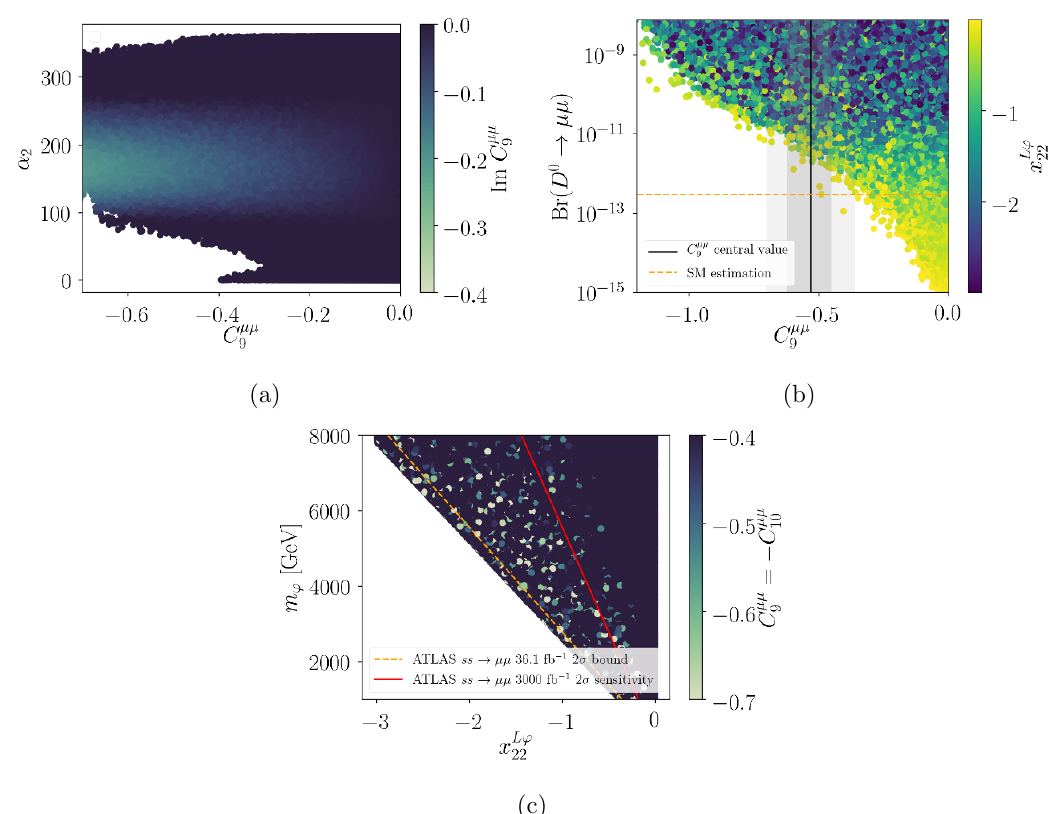
Figure 18. The other interesting results of our Monte Carlo analysis. (a) The relation between C (cid:22)(cid:22) and the Majorana phase (cid:11) 2 . The points shown pass all of the constraints considered in our 9 analysis. The colour axis represents the imaginary part of C (cid:22)(cid:22) . The plot shows the preference 9 away from a vanishing (cid:11) 2 , driven by the constraint Br( (cid:22) Au ! e Au), and the consistency of the available parameter space with a small imaginary part of C (cid:22)(cid:22) . (b) The results of the random scan 9 projected onto Br( D 0 ! (cid:22)(cid:22) ) and C (cid:22)(cid:22) . Points shown pass all constraints. Our model predicts 9 Br( D 0 ! (cid:22)(cid:22) ) & 10 (cid:0) 12 , about an order of magnitude larger than the SM estimate from ref. [139]. We note that our calculation is not valid below the dashed orange line since it only represents the new-physics contribution. (c) The plot shows the in(cid:13)uence of the ATLAS ss ! (cid:22)(cid:22) limits on the parameter space of our model. Coloured points lie in the 2 (cid:27) region of the b ! s (cid:12)t we use. Dark blue points cannot explain the b ! s data. The dashed orange line corresponds to the current ATLAS limit, while the solid red line is the 3000 fb (cid:0) 1 projection. The abrupt absence of points in the bottom left of the plot is due to the constraint D 0 ! (cid:22)(cid:22) .